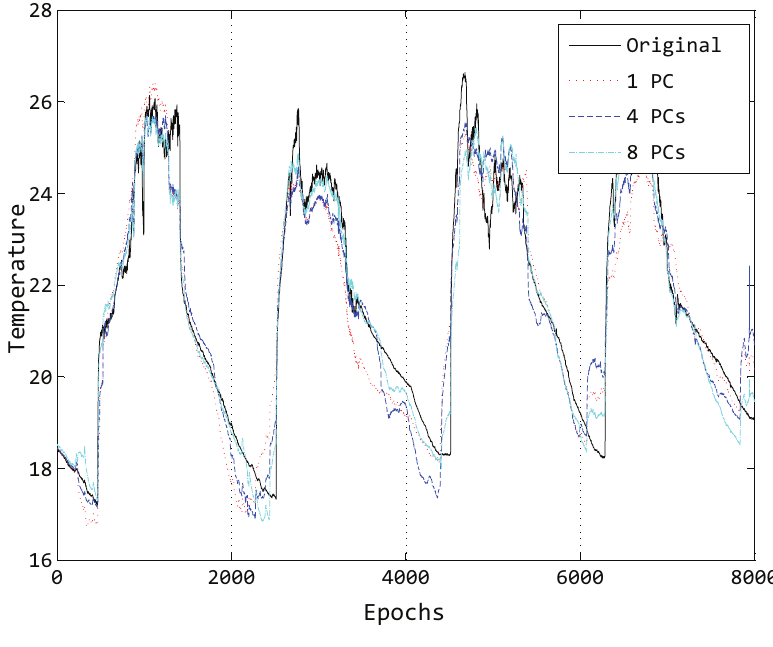
Figure 8. Compressed data of Sensor 1 by different